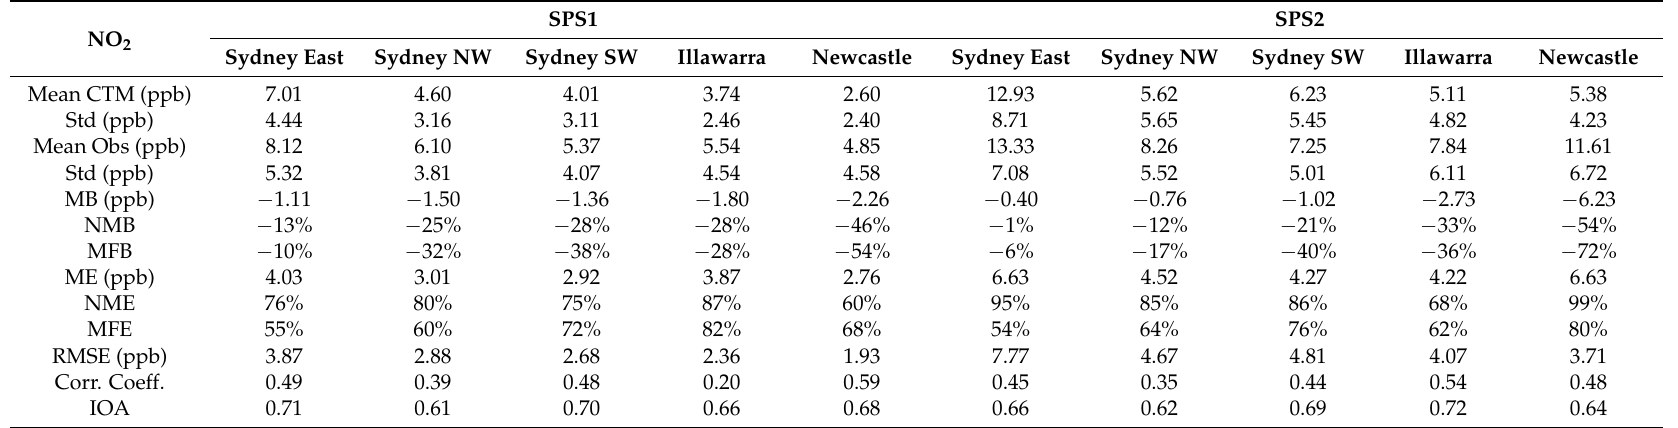
Table 4. Quantitative performance statistics for predicted hourly NO 2 concentration against observations in the Sydney East, Sydney NW, Sydney SW, Illawarra and Newcastle regions for the periods of SPS1 and